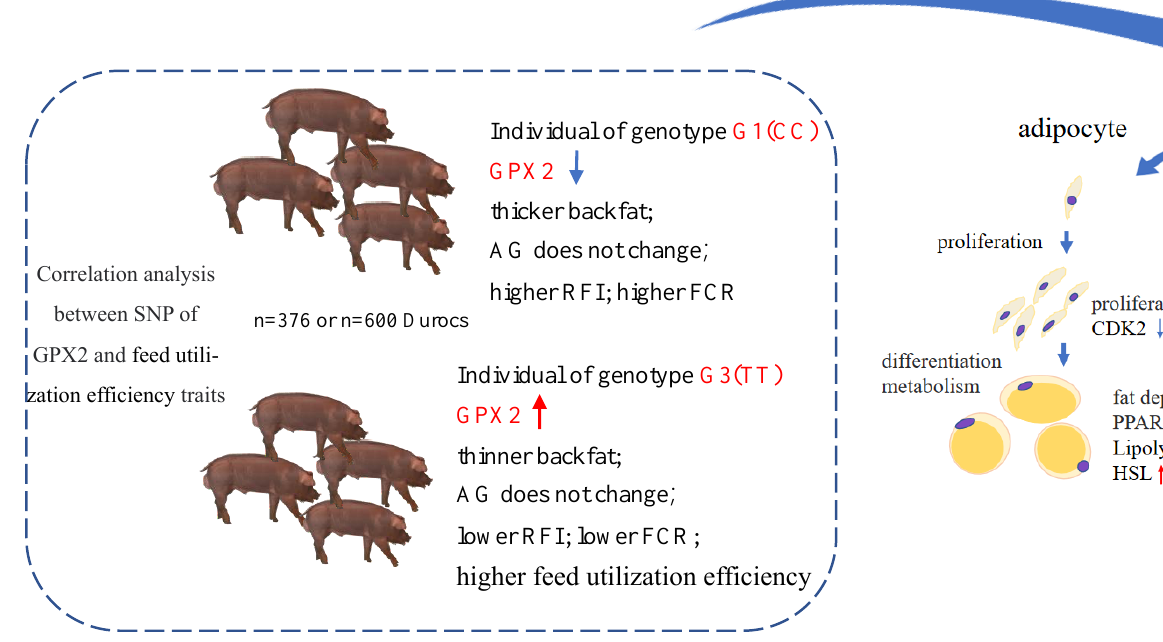
Figure 8. Hypothesis schematic models illustrating the GPX2 affects the backfat thickness and feed utilization efficiency of pigs by regulating the development of adipocytes and muscle cells. The left dashed box shows the correlation between SNP of GPX2 and feed utilization efficiency of Duroc pigs ( n = 376 or 600). The individual genotype G3(TT) of GPX2 has the thinner 100 kg backfat, lower residual feed intake, lower feed convers than G1(CC) individuals. The reason for this conclusion is that the GPX2 gene could inhibit the proliferation and differentiation of adipocytes, promote the degradation of fat (mechanism diagram on the right) and advance the proliferation and differentiation of muscle cells. After the high expression of GPX2, the nutrients in pigs were transferred to higher feed utilization efficiency. ↑ Indicates expression up-regulation, ↓ Indicates expression